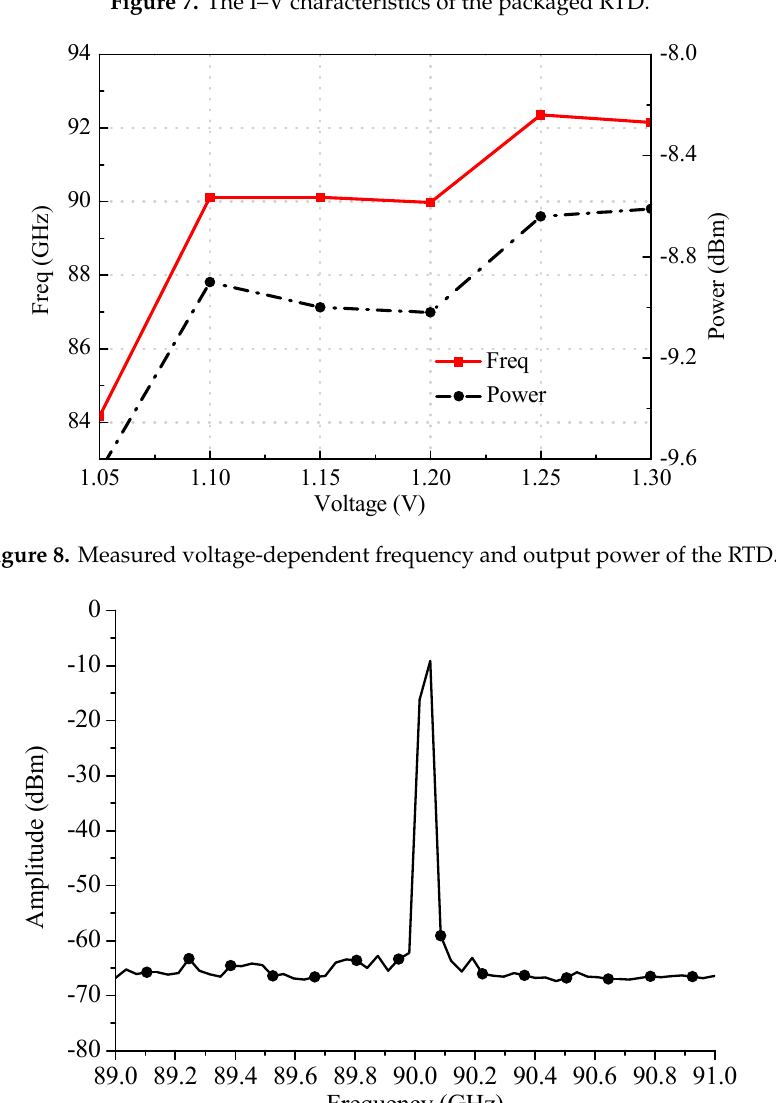
Figure 7. The I–V characteristics of the packaged RTD.